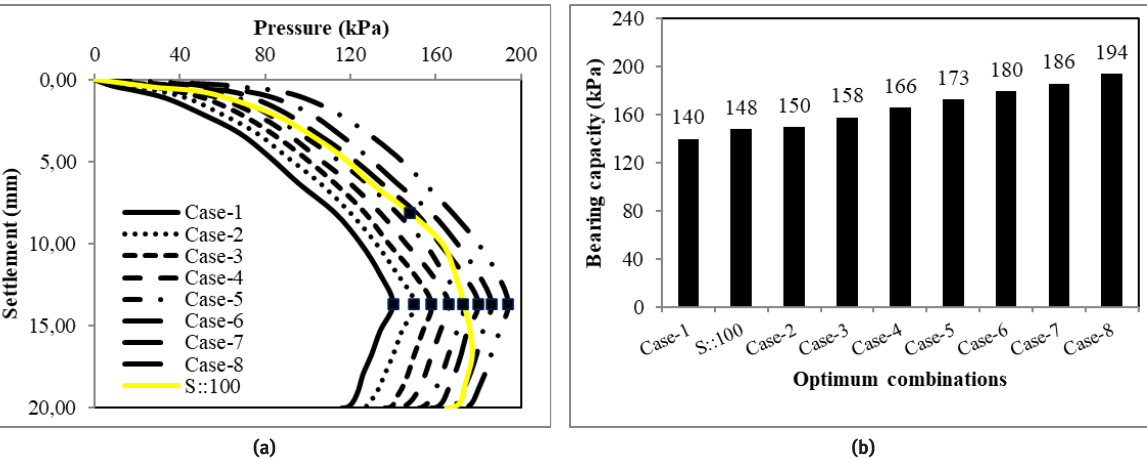
Figure 5: (a) Pressure–settlement curves and (b) bearing capacity values of two-layered soil for all cases at h/B=0.7 and single-layer sandy soil for L/B=1.